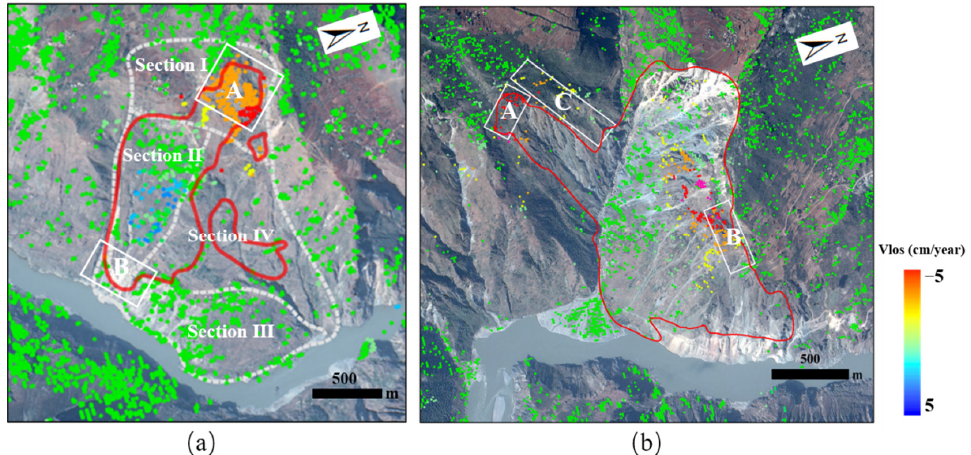
Figure 11. Comparison between the initial and final result: ( a ) comparison for the JPZ landslide, the white solid polygons indicate the two different parts between the initial and final result; ( b ) comparison for the SLT landslide, the white solid polygons indicate the parts with deformation. The red solid polygons indicate the final result. The white dotted line divides the five sections of the Jinpingzi landslide.